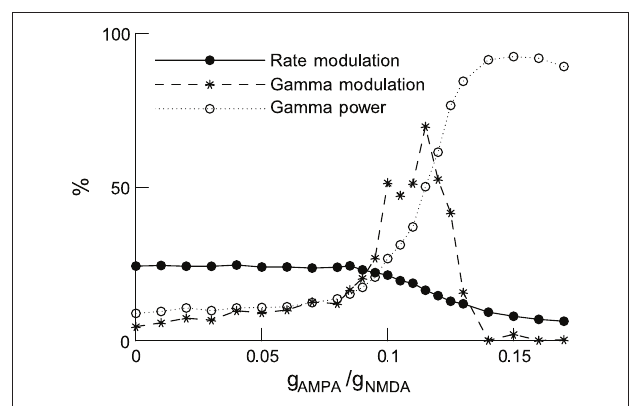
Figure 6 | in attention, rate and gamma modulations are not concomitant effects. Rate modulation (solid curve) and gamma modulation (dashed curve) as a function of the excitatory synaptic conductance ratio g / g . Increasing this ratio increases rhythmic gamma-band power AMPA NMDA (dotted curve), decreases the rate modulation monotonically while gamma modulation has a peak. Either of the two modulations can be dominant, depending on the gamma power. Figure modified from (Deco et